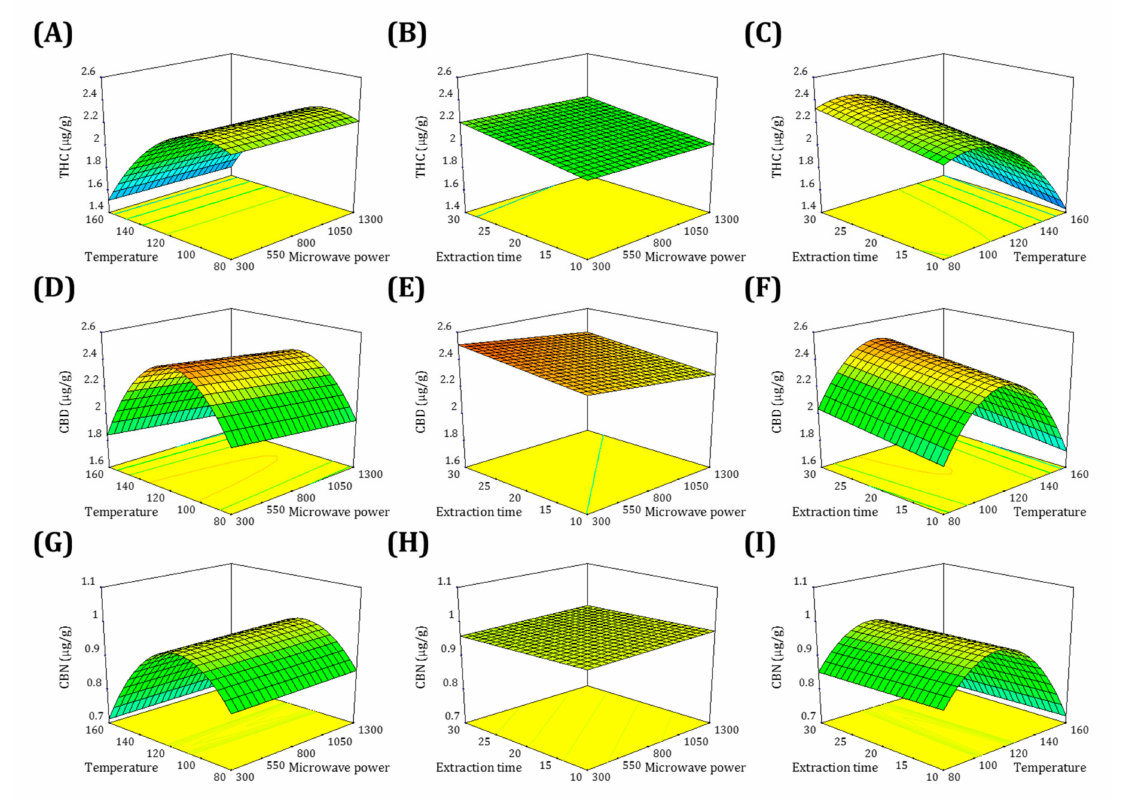
Figure 2. Response surface plots showing the interaction effects of microwave power, temperature, and extraction time on the yields of THC ( A – C ), CBD ( D – F ), and CBN ( G – I